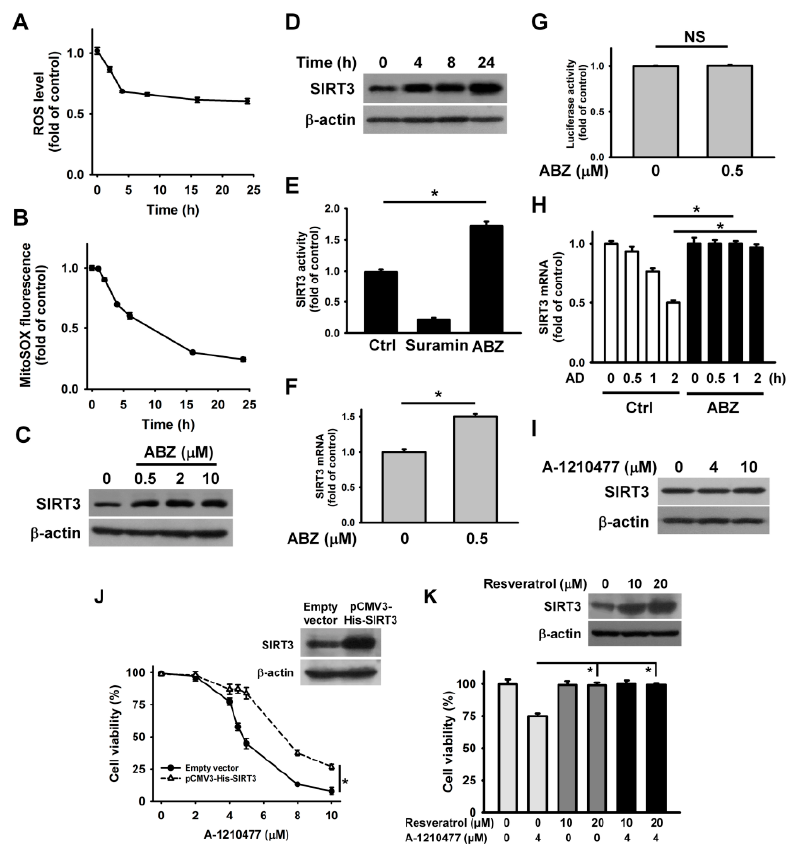
Figure 4. ABZ induced SIRT3 upregulation in K562 cells. Without specific indication, K562 cells were treated with 0.5 µ M ABZ for 24 h. ( A ) ABZ induced a reduction in ROS generation. K562 cells were incubated with ABZ for indicated time periods. Results were shown as fold-increase in fluorescence intensity compared with the control group. Each value is the mean ± SD of three independent experiments with triplicate measurements. ROS was quantified by the fluorescence plate reader. ( B ) Measurement of mitochondrial ROS generation using mitochondrial superoxide probe MitoSOX Red. K562 cells were incubated with ABZ for indicated time periods. The data represent the mean ± SD. E ff ect of ABZ induced SIRT3 expression in ( C ) concentration- and ( D ) time-dependent manners. ( E ) E ff ect of ABZ on SIRT3 deacetylase activity in K562 cells. A control experiment was also conducted using 5 mM suramin (a SIRT inhibitor), provided in the kit. Data represent mean ± SD ( * p < 0.05).